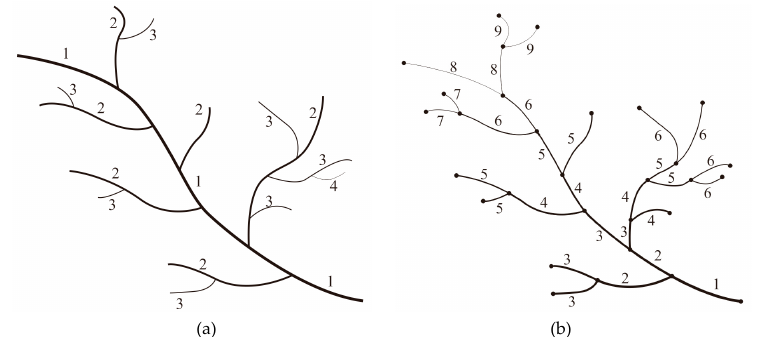
Figure 2. Bottom-up coding system for dendritic river features: ( a ) Hack coding based on river streams and ( b ) Marani coding based on river segments.